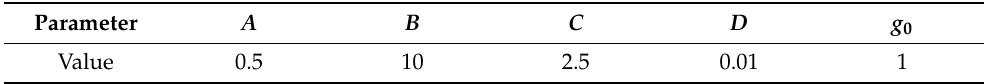
Table 1. Dimensionless parameters of CBN film growing